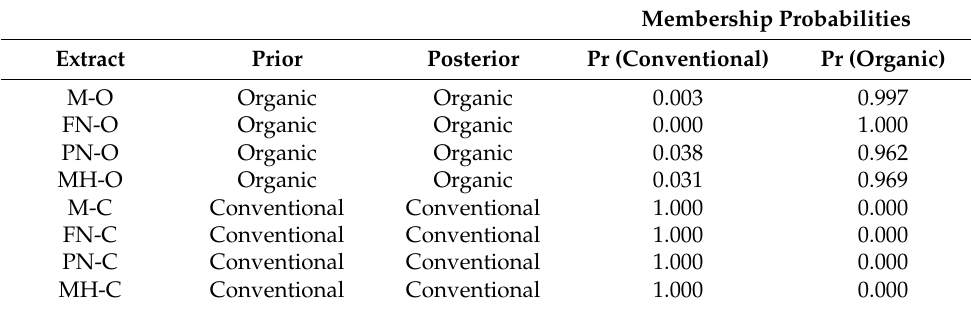
Table 4. Prior and posterior classification of the red grape skin extracts using PC-DA (Raman spectral data).